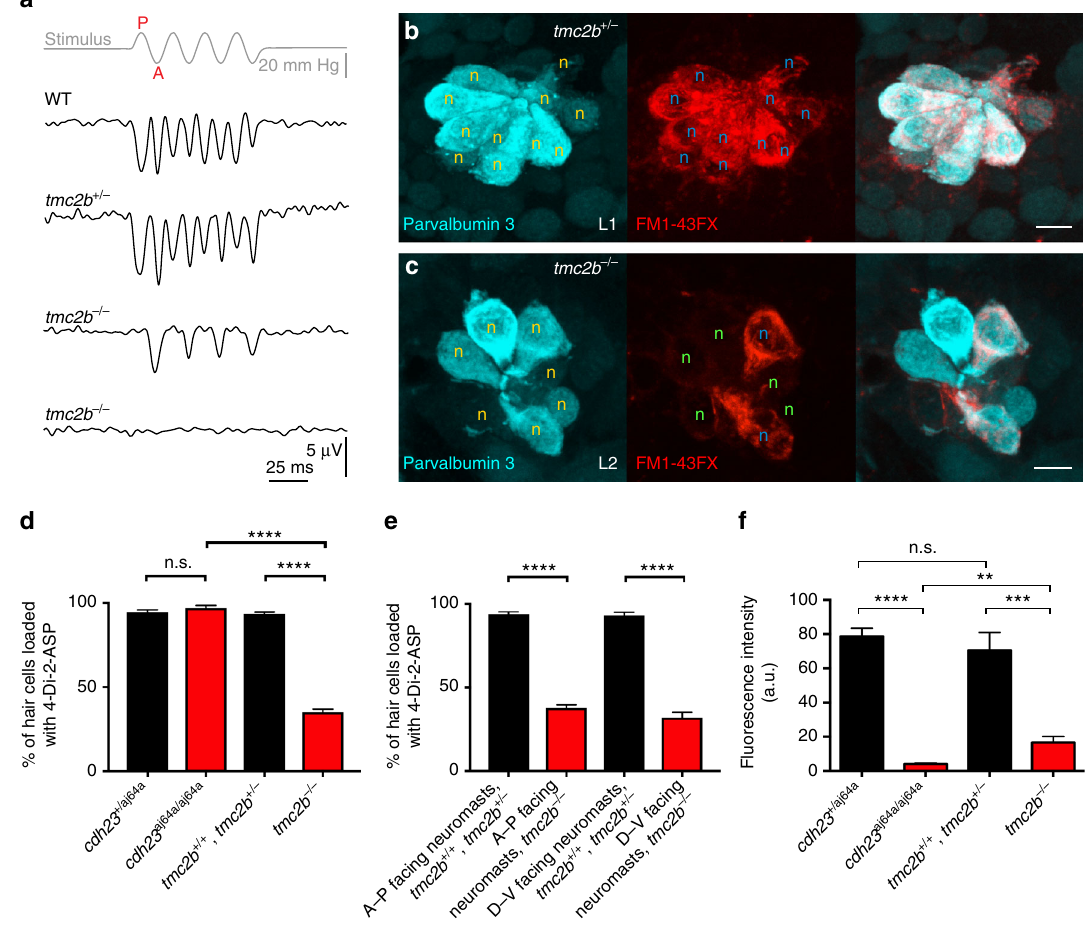
Fig. 3 Variable dependence on Tmc2b for mechanotransduction in posterior neuromast hair cells. a Extracellular recordings of microphonic potentials measured from posterior neuromasts with A-P orientations of 6-dpf zebra fi sh larvae are displayed. The responses in tmc2b − / − are often absent, bottom trace ( n = 9/15); however, several responses ( n = 6/15) are highly asymmetric, with weakened amplitude for one direction of stimulus and no response for the other direction, penultimate trace. De fl ection anteriorly (A) or posteriorly (P). b , c Qualitative confocal images of hair cells labeled with FM1-43FX (red), to assess mechanotransduction function, and parvalbumin 3 (cyan) 50 , as a counter label, to visualize mature hair cells. b A posterior neuromast from a tmc2b + / − animal demonstrates co-labeling of all hair cells. c In a tmc2b − / − animal, a posterior neuromast contains hair cells that label with FM1-43FX and a subset that do not (label:no label; 2:5). Orange n, hair cells labeled with parvalbumin 3 antiserum. Blue n, hair cells that load with FM1-43FX. Green n, hair cells that do not load. Scale bar = 5 μ m. d , e Percentages of hair cells within PLL neuromasts that label with 4-Di-2-ASP. d In neuromasts of tmc2b + / + and tmc2b + / − animals, most hair cells take up fl uorophore. Approximately 35% of hair cells in each PLL neuromast of tmc2b − / − fi sh take up 4-Di-2-ASP. In contrast, in cdh23 aj64a/aj64a mutants, all hair cells take up dye, though at much lower quantities than wild-type animals (see f and Supplementary Fig. 4b). **** Kruskal – Wallis test P value < 0.0001. n values ≥ 20. e In mutants, A – P-facing and D – V-facing posterior neuromasts have similar percentages of hair cells that gather fl uorophore, ~38 and 32%, respectively. ****Student ’ s t -test P value < 0.0001. n values ≥ 23. f Mean fl uorescence intensity of 4-Di-2-ASP uptake of the brightest cell per neuromast. n values ≥ 17. Kruskal – Wallis test **** P < 0.0001, *** P = 0.001, ** P = 0.0215 demonstrate that Tmc2b is necessary for normal mechanotrans- duction in posterior neuromast organs with A – P orientations.